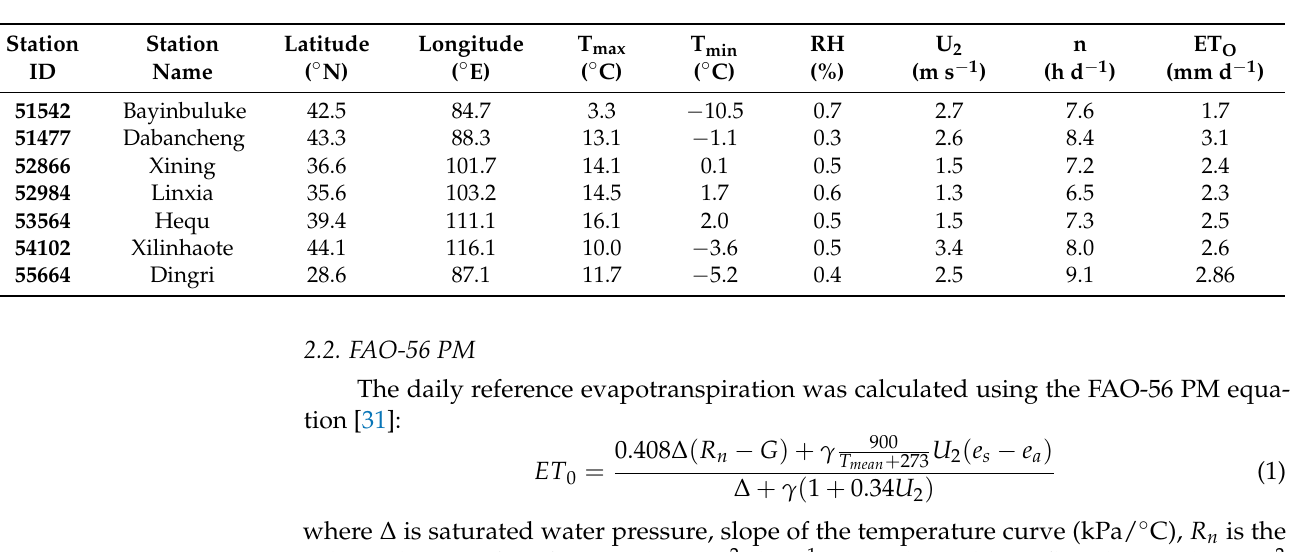
Figure 2. Raw data preprocessing. Table 1. Geographical locations and mean daily values of the meteorological data.